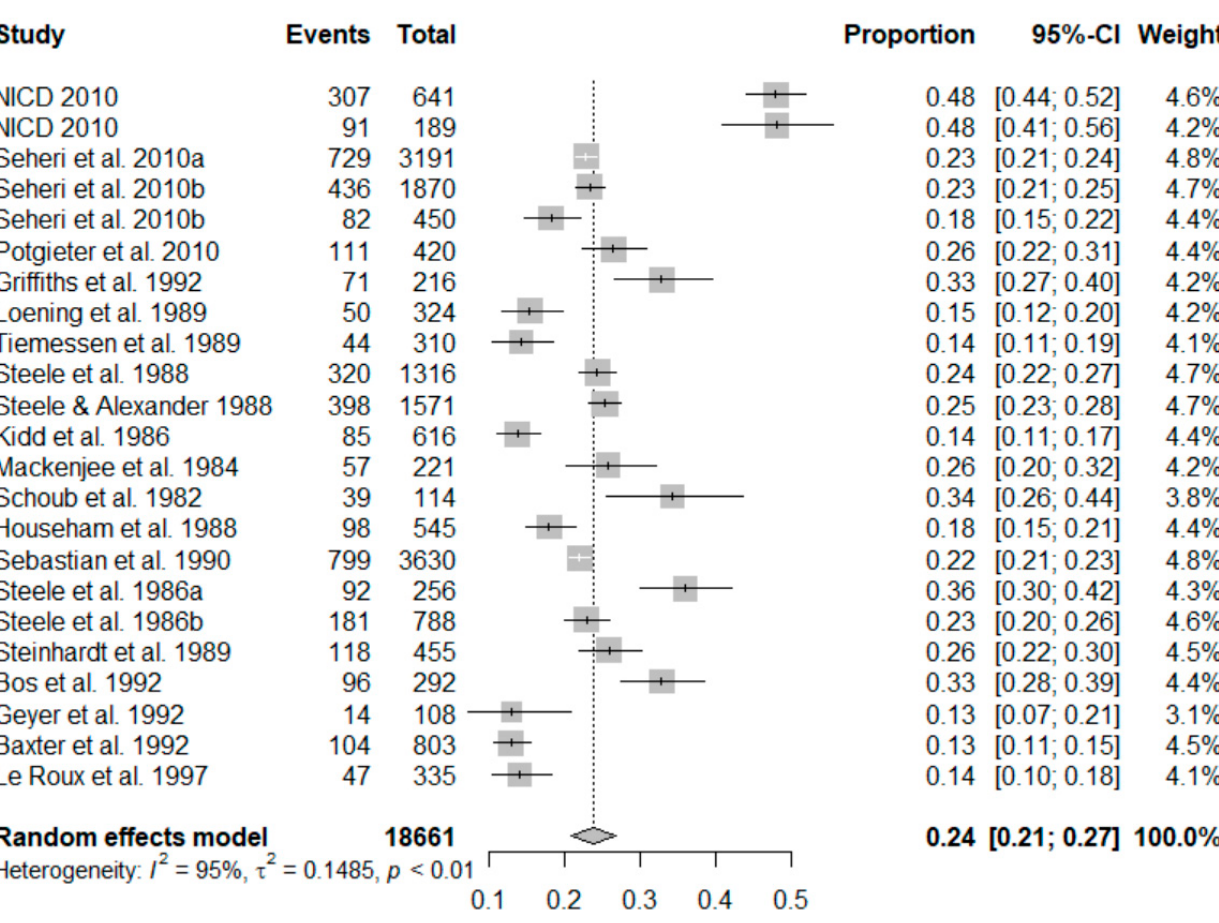
Figure 2. Forest plot showing the pooled prevalence of rotavirus cases before the inclusion of rotavirus vaccination in South Africa.